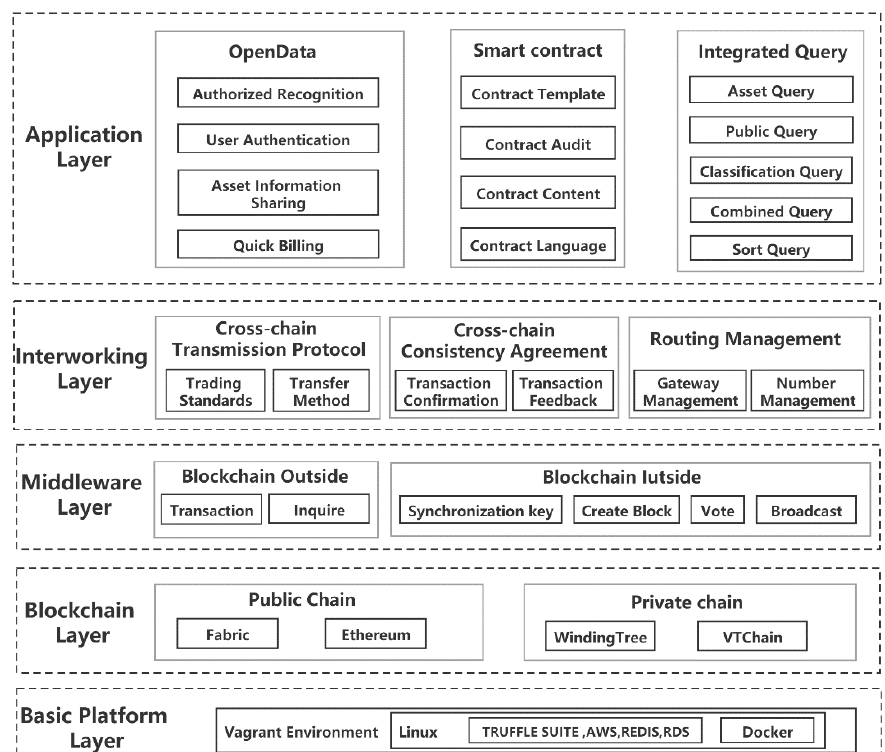
Figure 2. The layered architecture of the multi-chain.